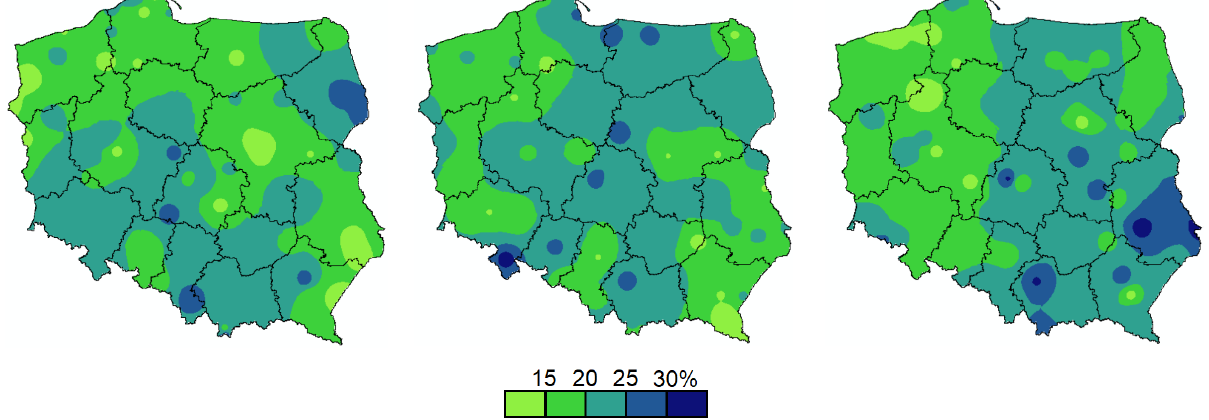
Figure 12. Frequency of precipitation deficits in Poland in consecutive months of spring (from March to May) of different degrees of intensity: high, medium and low. Years 1951 – 2018.